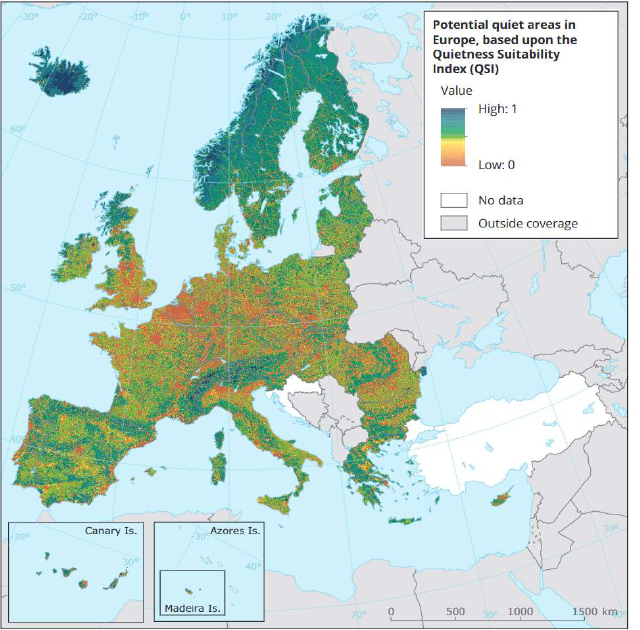
Figure 2. Potential peaceful areas in Europe, based on the Silence Convenience Index